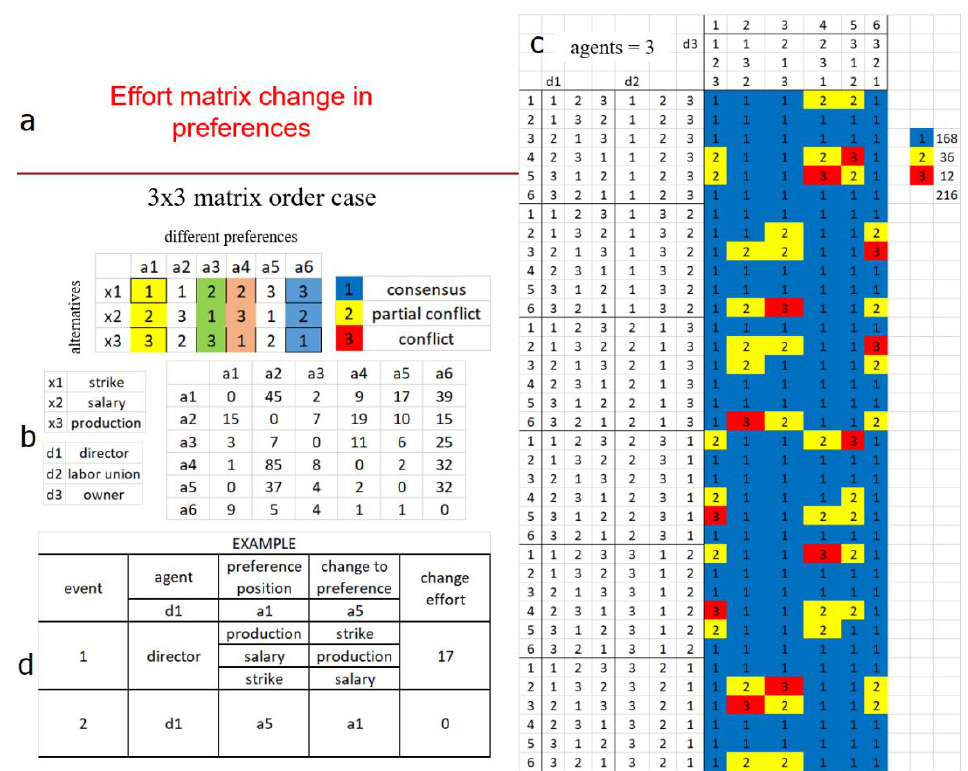
Figure 26. Cost decision conflict heatmap to achieve consensus. ( a ) Effort matrix change in prefer- ences, ( b ) Example of a change effort matrix, ( c ) Example of a color map (or heatmap) associated to a decision matrix and ( d ) Example built over change effort matrix of ( b )